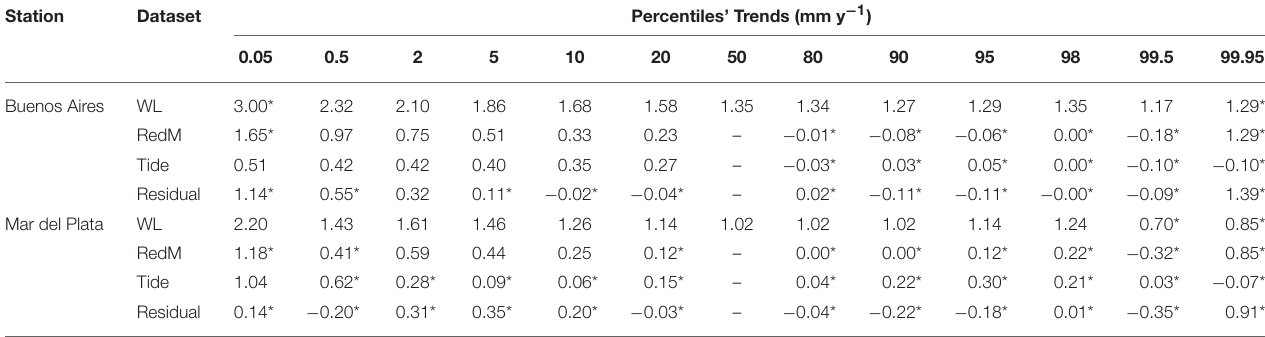
* Not significant with a 5% of significance